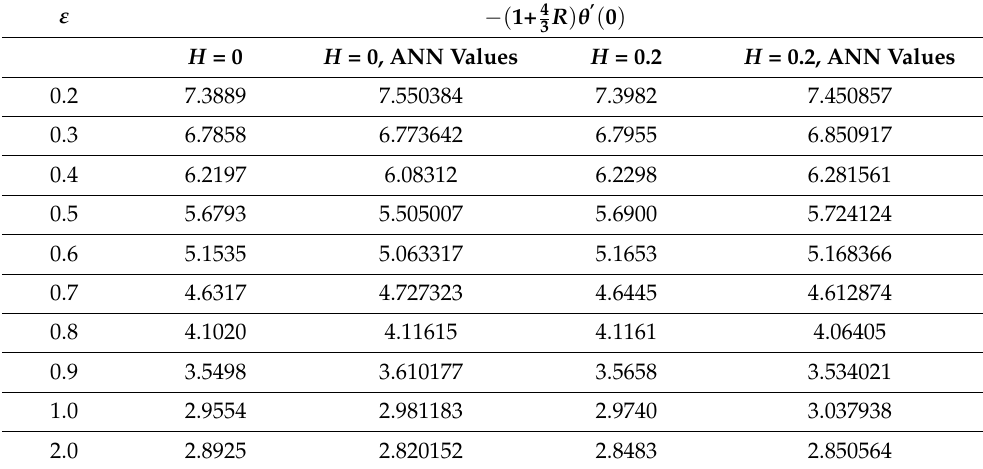
Table 1. Impact of variable thermal conductivity on Nusselt number with and without heat generation.